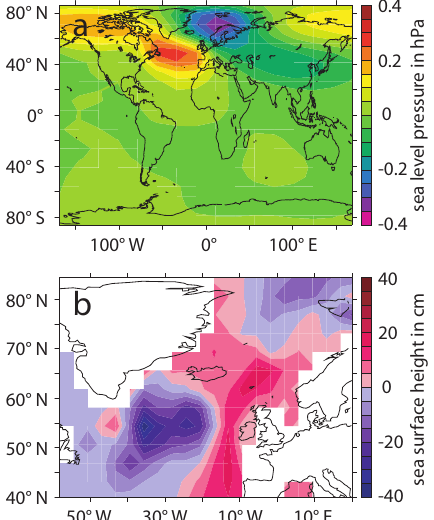
Fig. 7. Sea level pressure (a) and sea surface height (b) difference of strong minus weak SPG state with 100yr period sinusoidal fresh- water forcing of 20mSv